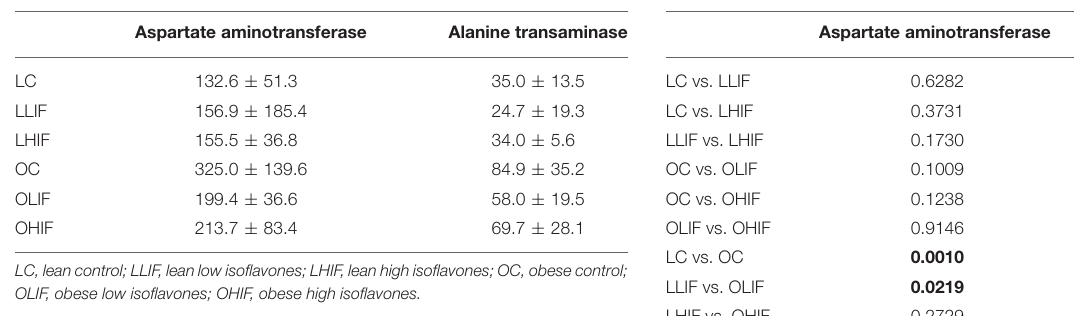
TABLE 5 | Significance level ( p -value) of pairwise contrasts between lean and obese rats on low and high diet isoflavones for aspartate aminotransferase and alanine